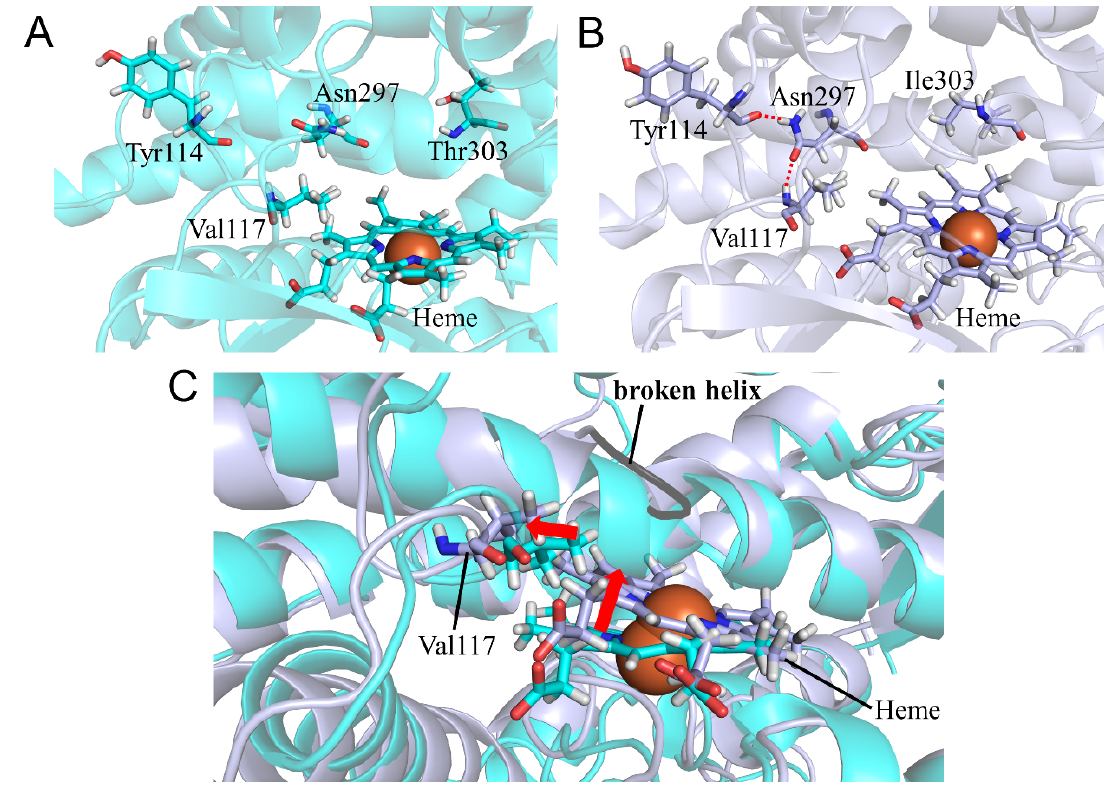
Table 8. Hydrogen bond formation involved in the structural change in CYP2A6.43.